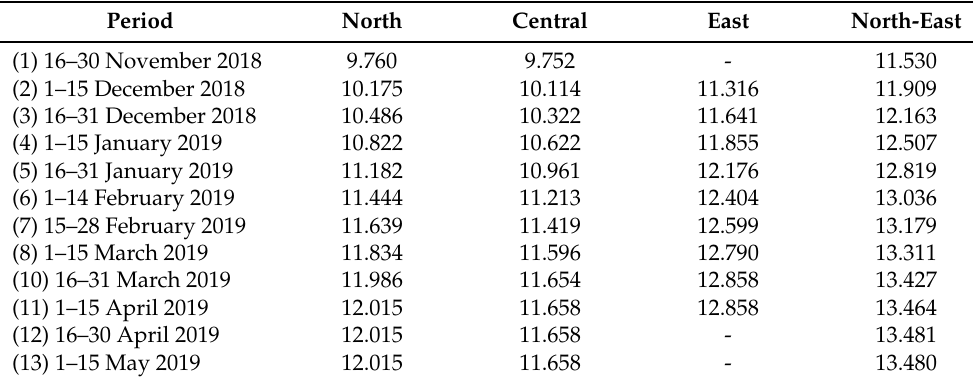
Table 3. The Commercial Cane Sugar System (CCS) value in each region for crop year 2018/19.